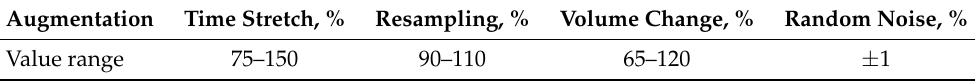
Table 2. Range of values for different data augmentation